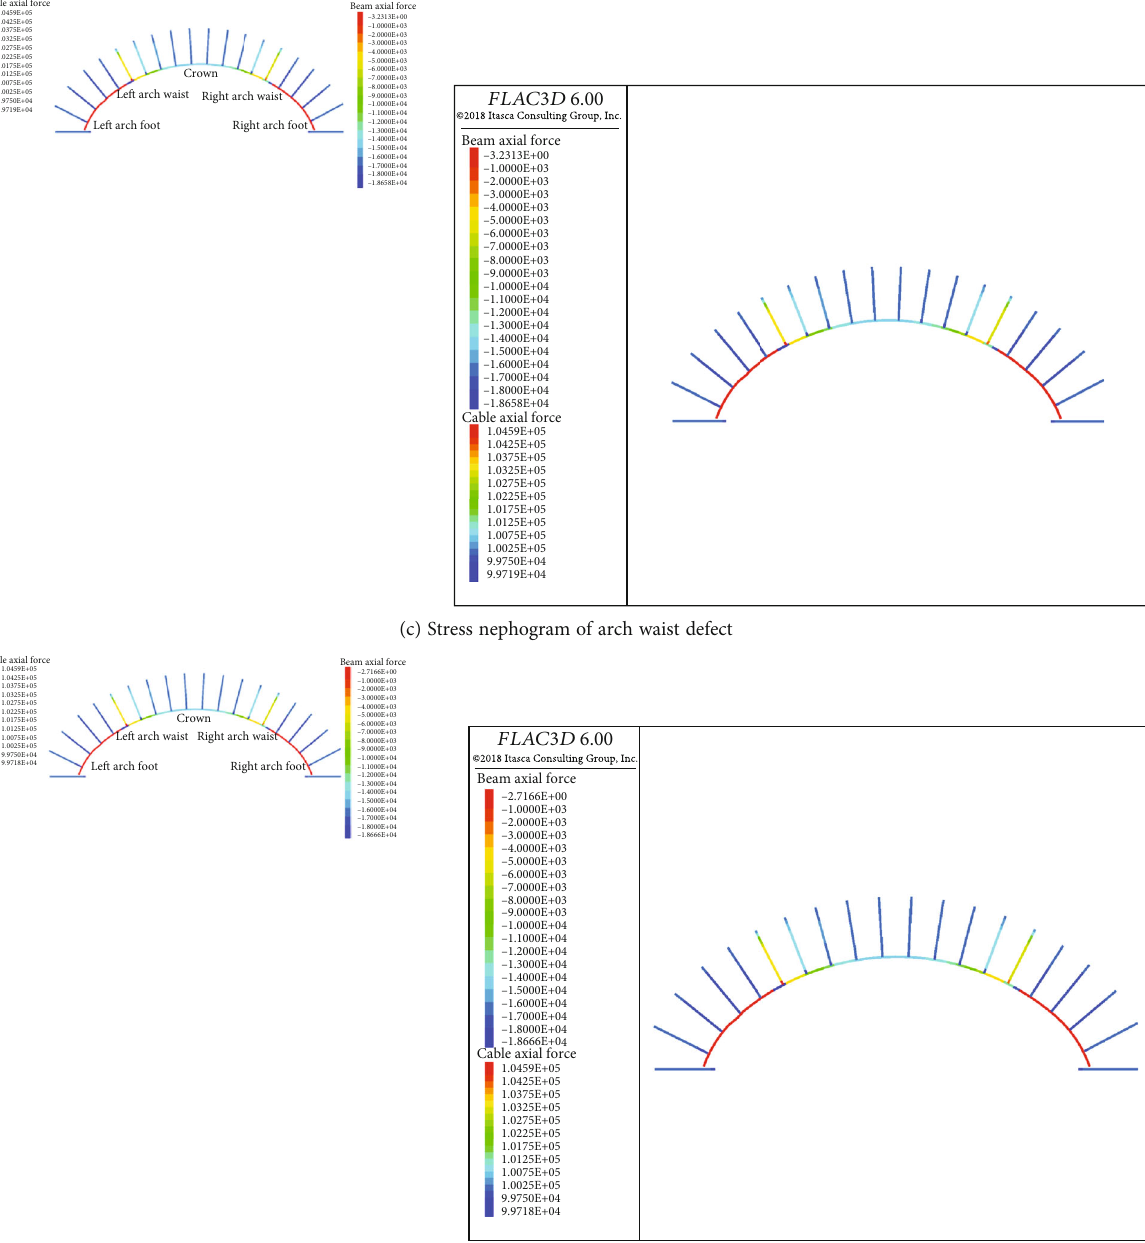
Figure 11: Stress nephogram of grid